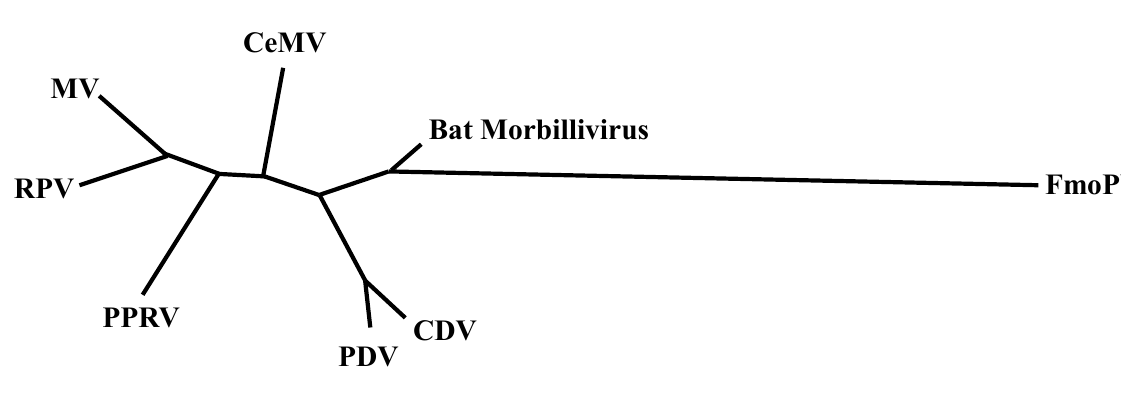
Figure 1. An unrooted maximum likelihood phylogenetic tree of morbilliviruses was estimated under the general time-reversible model using PhyML software version 3.0 [5], using partial large (L) gene nucleotide sequences (GTR + I + G